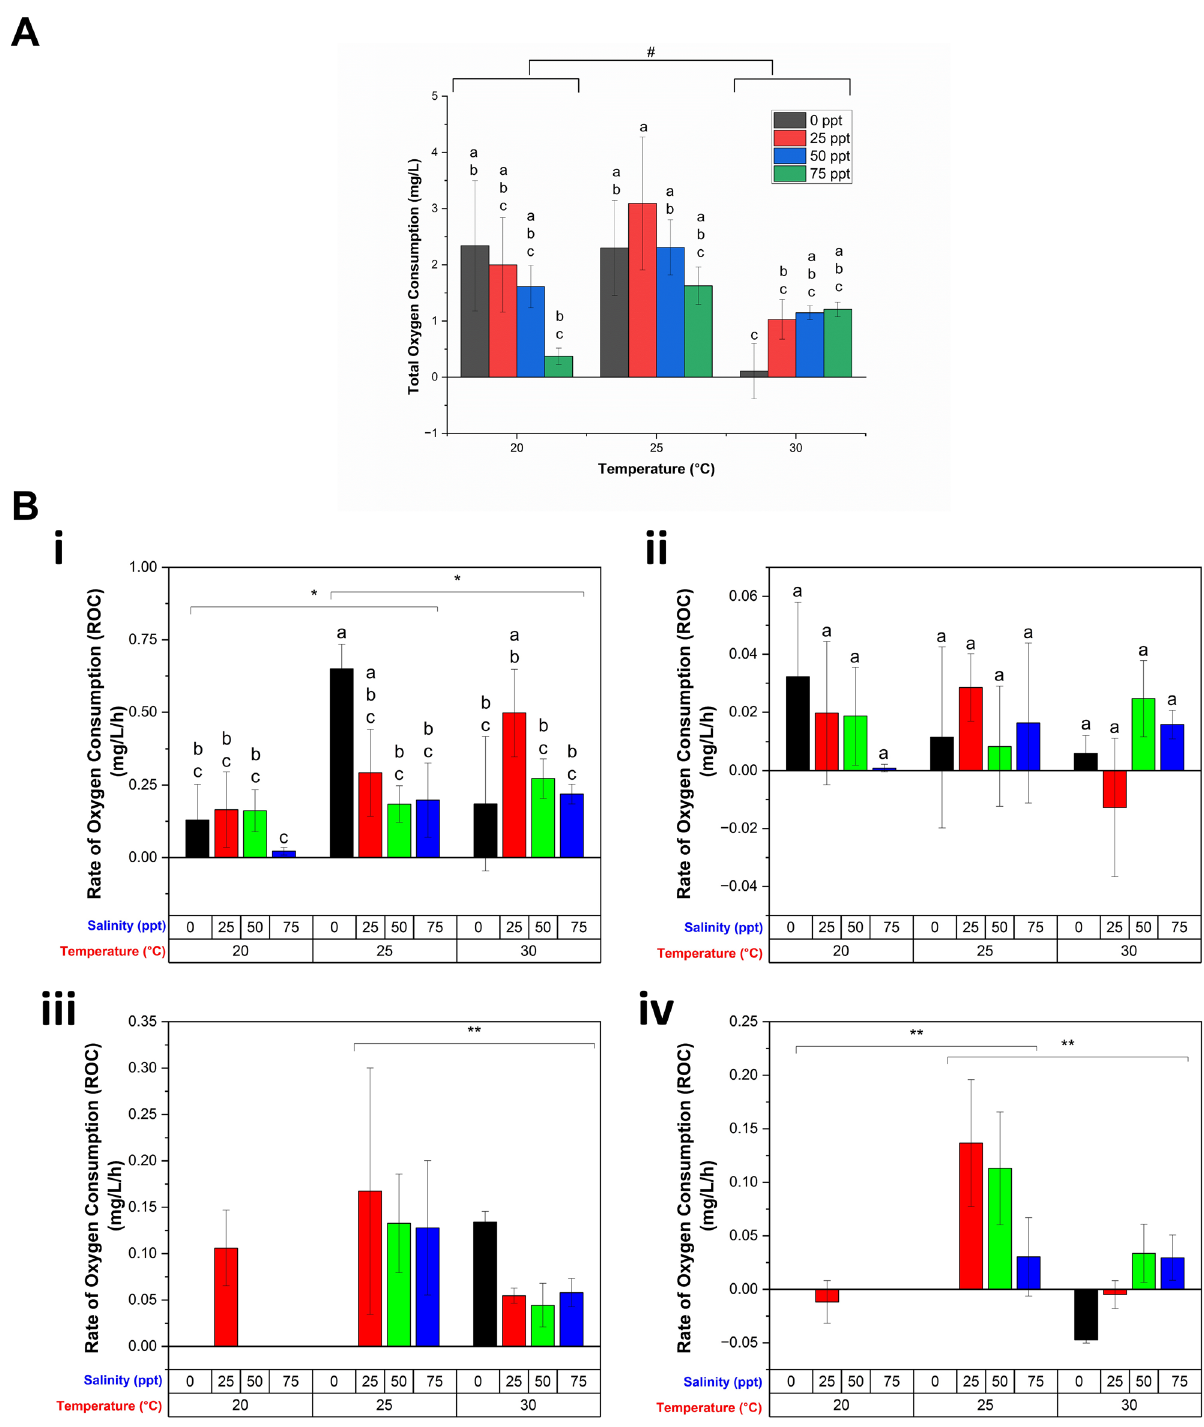
Figure 4. Oxygen consumption of the Artemia cysts under different temperatures and salinities. ( A ) Total oxygen consumption, or total DDOC throughout the entire hatching process under different temperature and salinities. ( B ) Rate of oxygen consumption (ROC) at different stages of hatching: (i) hydration, (ii) differentiation, (iii) emergence, and (iv) hatching stage. Values are expressed as mean ± standard deviation (n = 3). In each category of data (total oxygen consumption, or ROC in hydration and differentiation stages), means that do not share letters above the columns are substantially different from each other (two-way ANOVA with Bonferroni post-hoc test, p < 0.05). At different tested temperature, statistically significant ROC was indicated by * (two-way ANOVA with Bonferroni post-hoc test, p < 0.05) and ** (one-way ANOVA with Bonferroni post-hoc test, p < 0.05) respectively, whereas # indicates statistically significant total oxygen consumption (two-way ANOVA with Bonferroni post-hoc test, p <